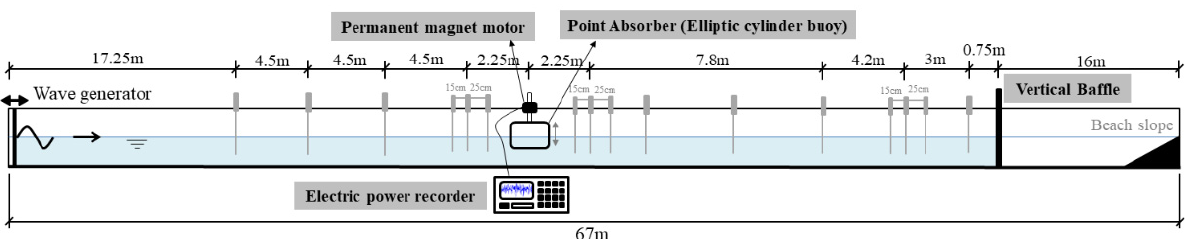
Figure 10. Experimental devices layout diagram for fully standing wave cases.